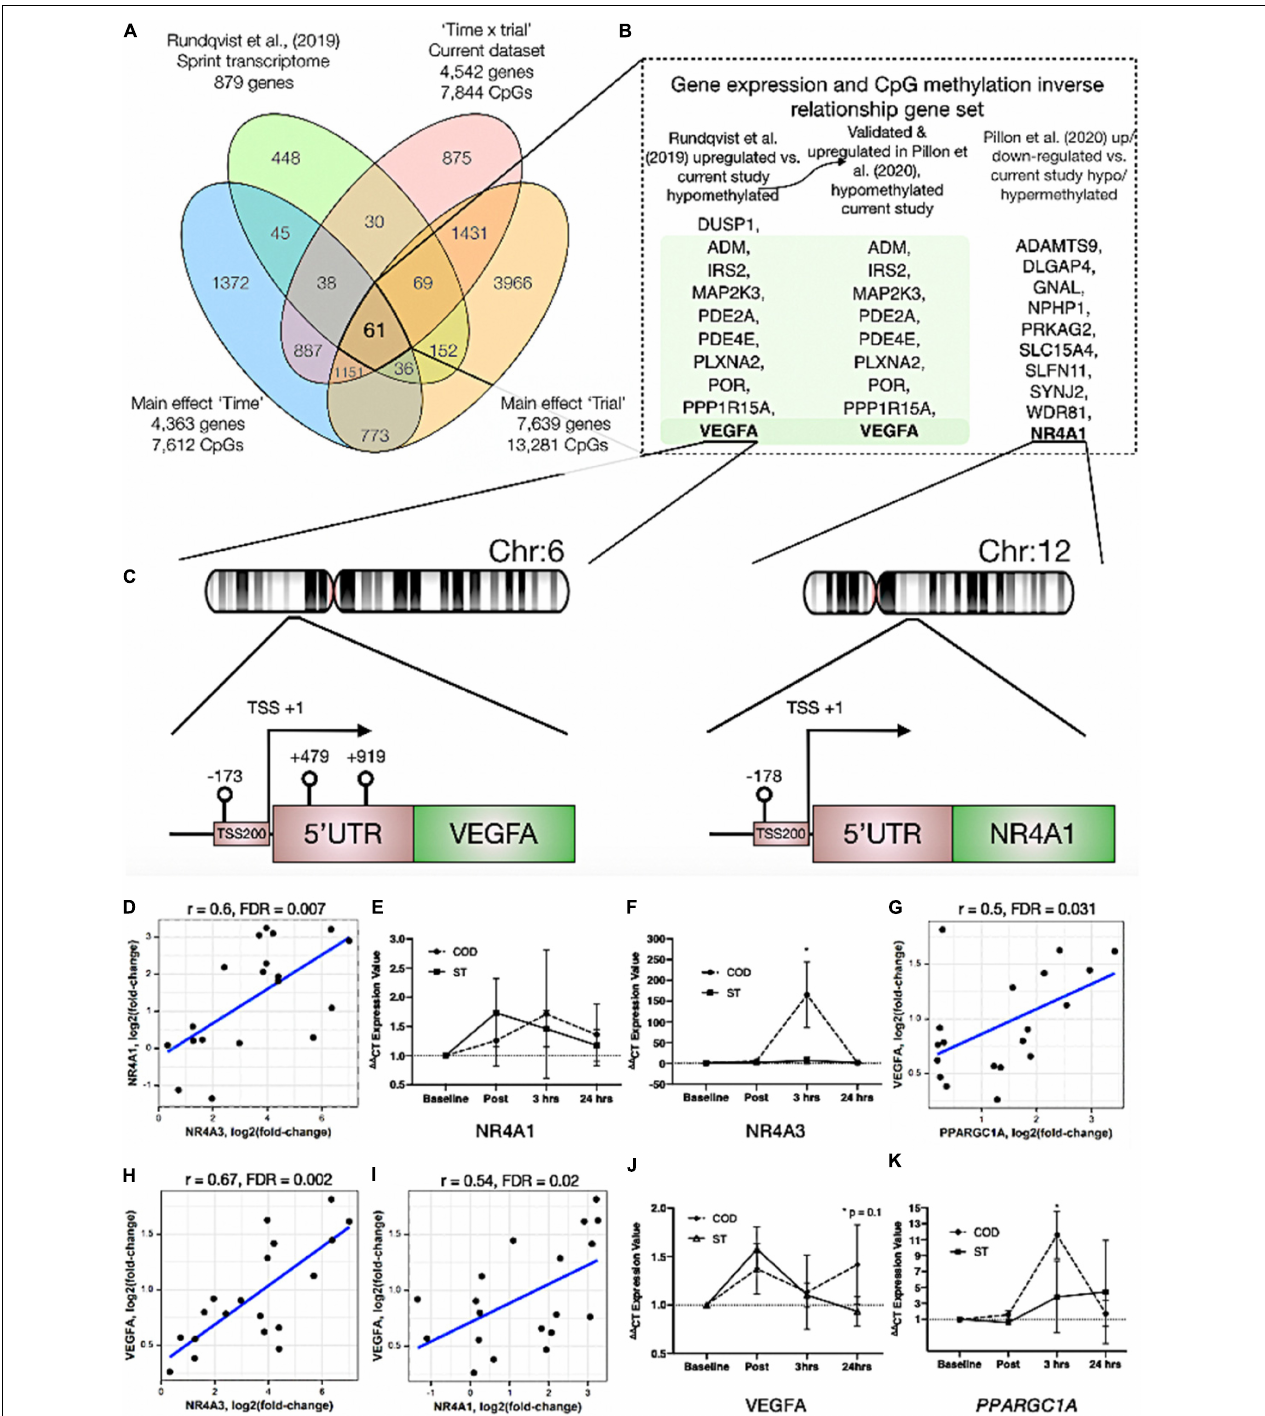
FIGURE 4 | (A) Venn diagram analyses of the overlap between the sprint transcriptome (Rundqvist et al., 2019) and differential methylome analysis in the present study. A total of 431 genes overlapped with the sprint transcriptome and were identified as significant DMPs in at least one of the methylome analyses in the present study. Sixty one genes were and up/down regulated in the sprint transcriptome and significantly differentially methylated across all methylome analyses in the present study. (B) Genes (shaded in green) out of the 61 identified in (A) , that were significantly upregulated in the sprint transcriptome (Rundqvist et al., 2019), upregulated in acute aerobic exercise transcriptome meta-analysis (Pillon et al., 2020) as well as hypomethylated in all methylome analyses in the present study. Unshaded genes were upregulated in acute aerobic exercise transcriptome meta-analysis (Pillon et al., 2020) (but not changed in the sprint transcriptome)